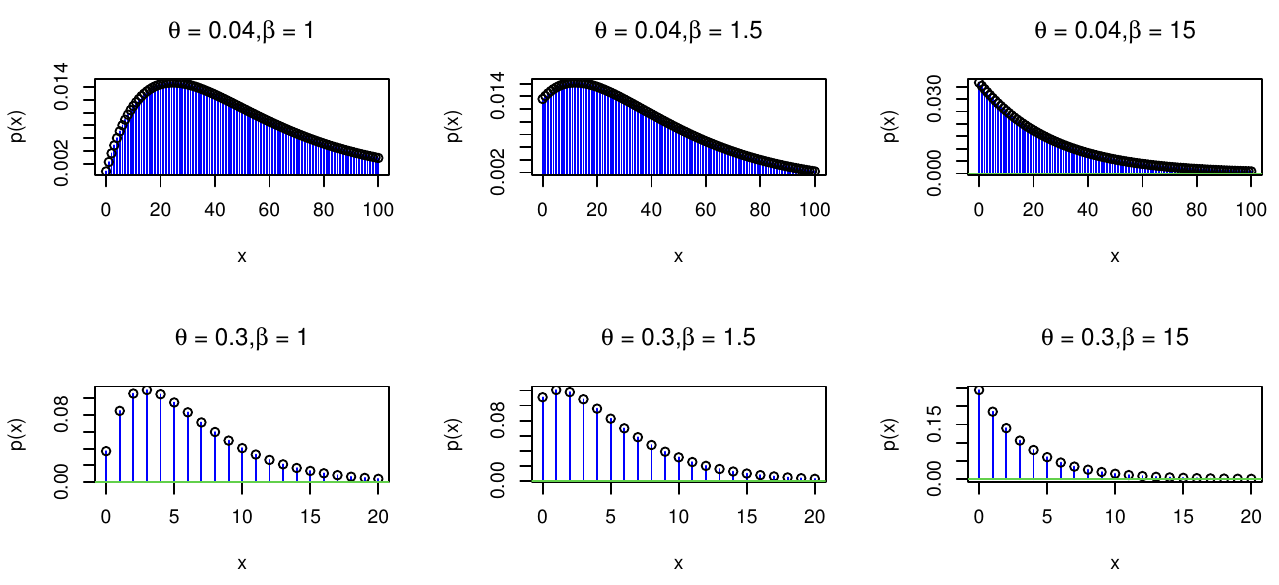
Figure 1. The pmf plots of the DPsL distribution for some set of values for θ and β . The figure clearly indicates that the DPsL distribution is rightly skewed and has a longer right